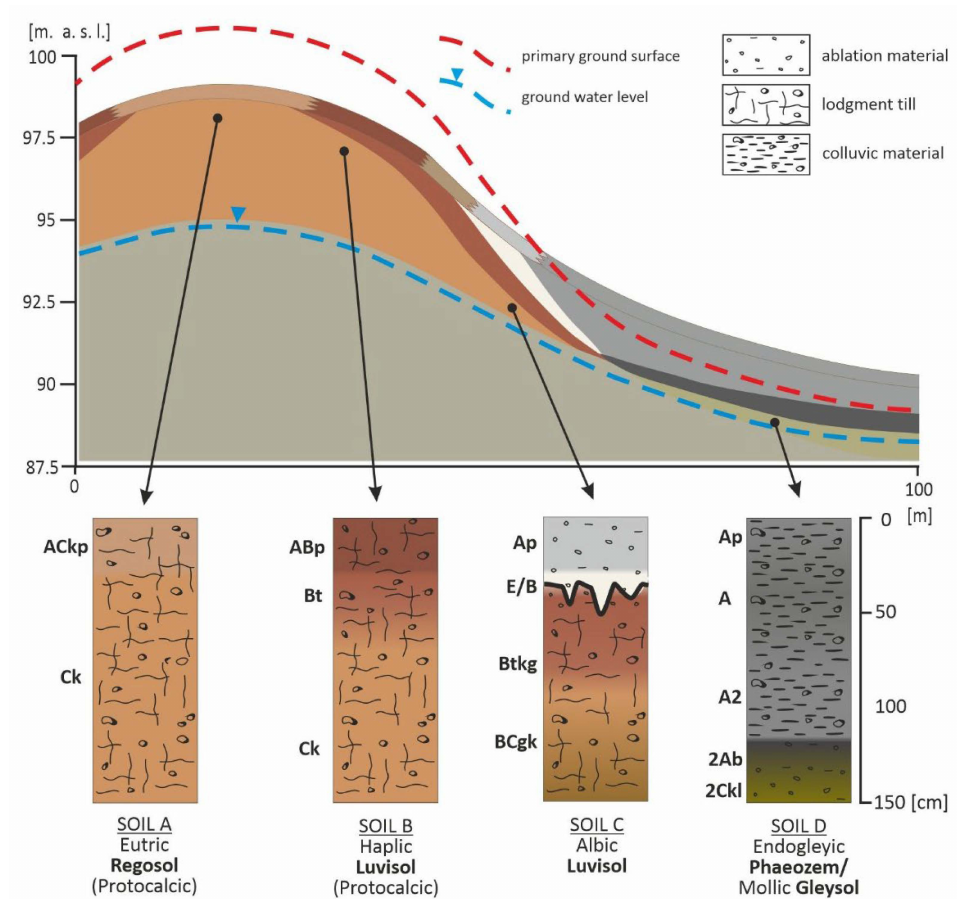
Figure 1. An erosion catena within the Orzechowo experimental